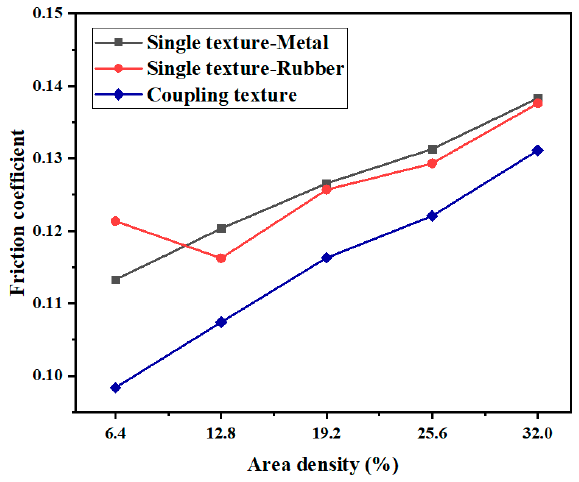
Figure 8. Variation of friction coefficient with area density.